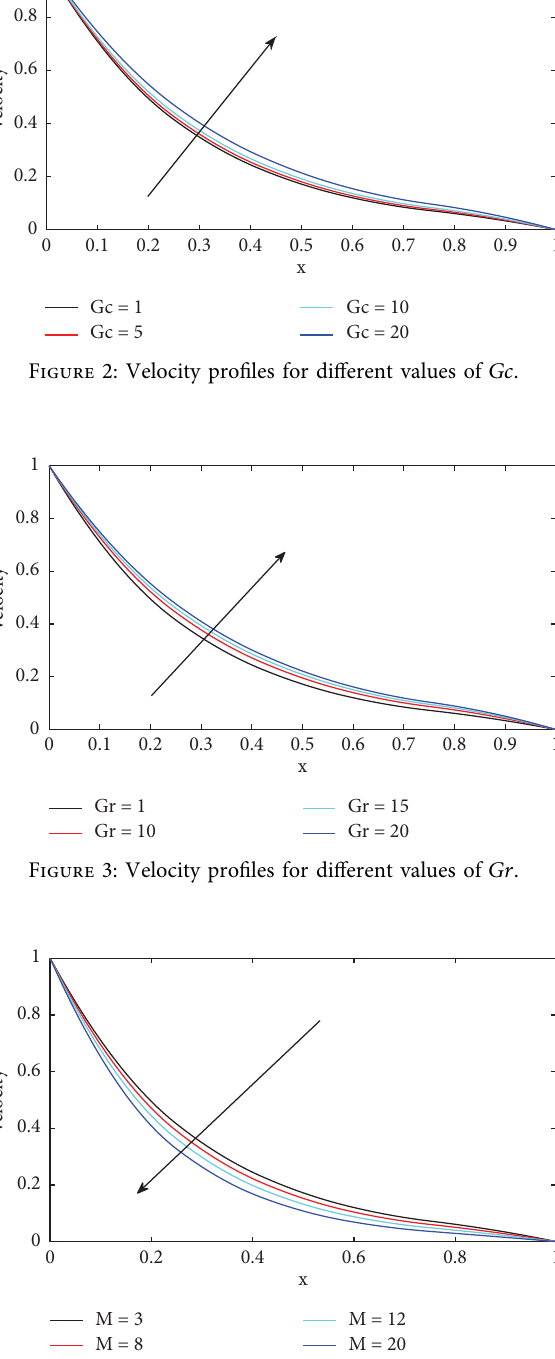
Figure 4: Velocity profles for diferent values of M